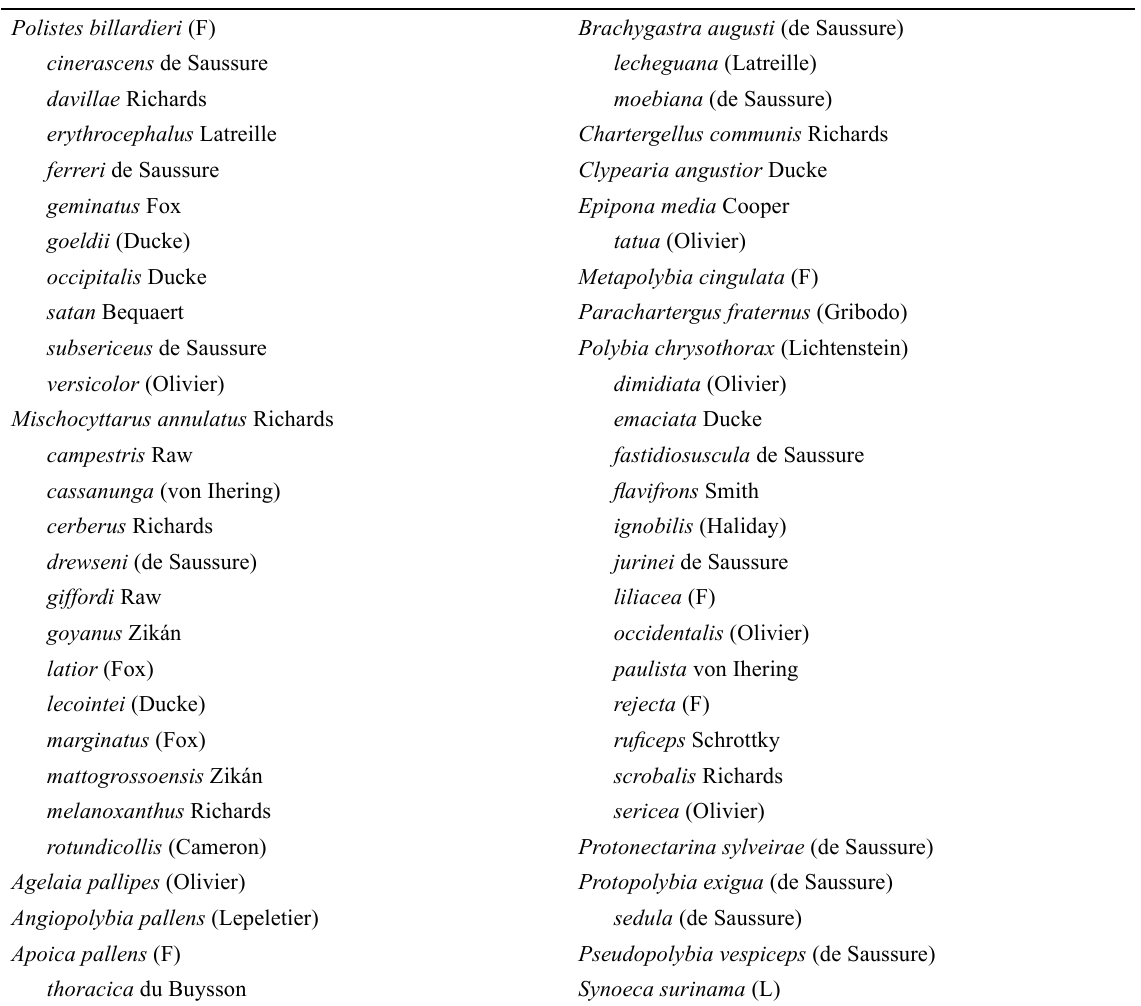
Table 1. List of the 56 species of social wasps recorded in and around the Federal District of Brasília.